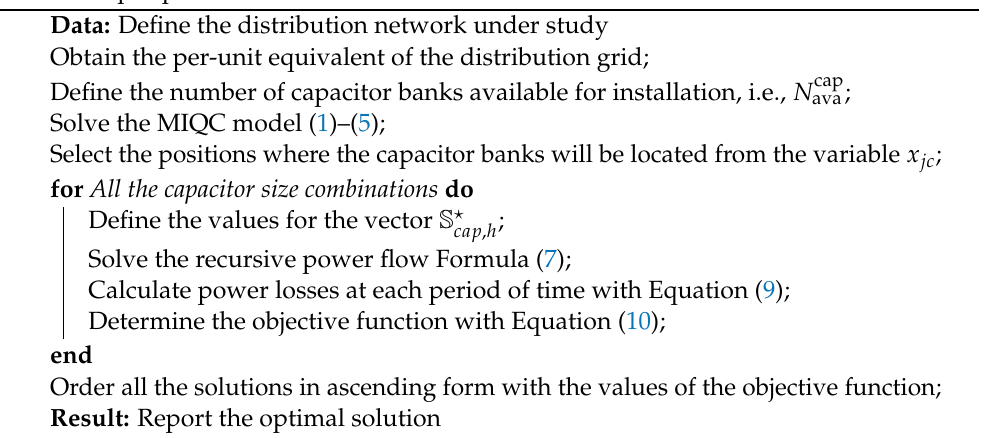
Algorithm 1: Proposed two-stage solution methodology to select and locate fixed-step capacitor banks in distribution